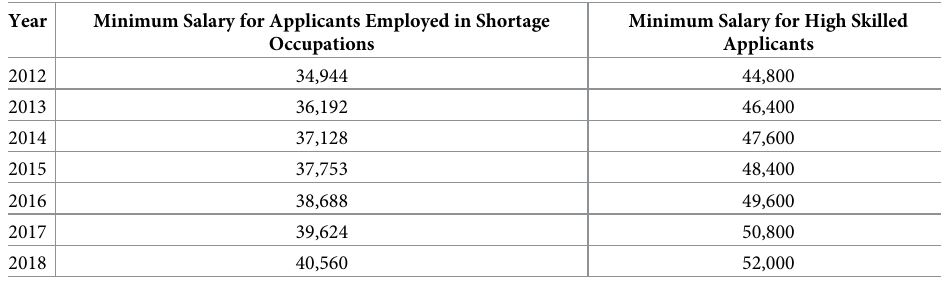
Table 1. Minimum salary required for the EU Blue